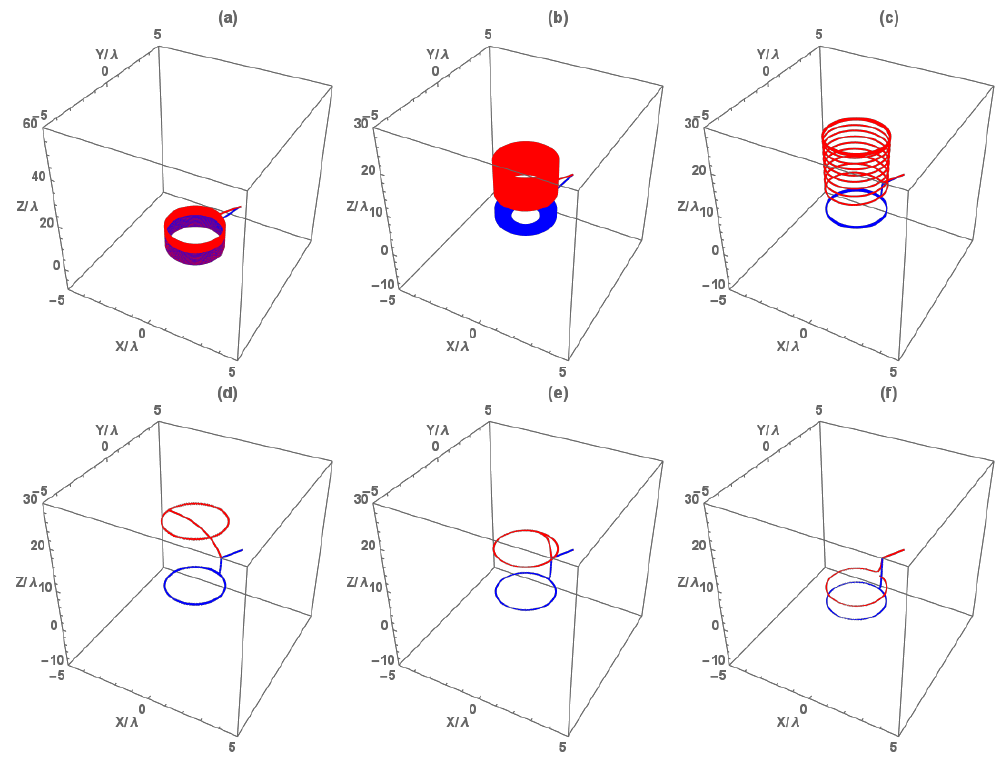
Figure 2. Particle trajectories for different τ values and for both enantiomers ( δ > 0 blue and δ < 0 red). ( a ) τ = 0 Hz, ( b ) τ = 2 Hz, ( c ) τ = 10 Hz, ( d ) τ = 500 Hz, ( e ) τ = 1 kHz, and ( f ) τ = 5